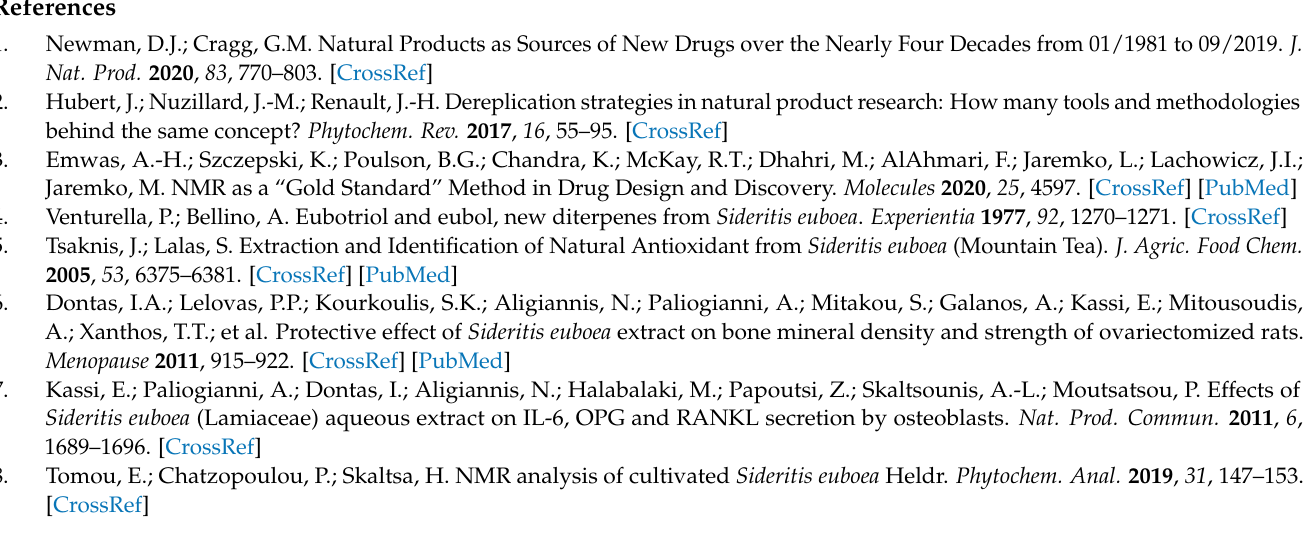
Supplementary Materials: Figure S1: 1 H-NMR spectrum of EtOAc residue of cultivated S. euboea (CD 3 OD, 400 MHz), Figure S2: COSY spectrum of EtOAc residue of cultivated S. euboea (CD 3 OD, 400 MHz), Figure S3: HSQC spectrum of EtOAc residue of cultivated S. euboea (CD 3 OD, 400 MHz), Figure S4: HMBC spectrum of EtOAc residue of cultivated S. euboea (CD 3 OD, 400 MHz), Table S1: Chemical structures of the isolated compounds 1–33, Figure S5: Best pose of the interaction of compound 12 with hyaluronidase. The pi-stacking interactions are shown with light blue dashed lines and the hydrogen bonds with yellow dashed lines. Figure S6: Best pose of the interaction of compound 13 with hyaluronidase. The pi-stacking interactions are shown with light blue dashed lines and the hydrogen bonds with yellow dashed lines. Figure S7: Best pose of the interaction of compound 17 with hyaluronidase. The pi-stacking interactions are shown with light blue dashed lines and the hydrogen bonds with yellow dashed lines. Figure S8 Best pose of the interaction of compound 18 with hyaluronidase. The pi-stacking interactions are shown with light blue dashed lines and the hydrogen bonds with yellow dashed lines. Figure S9. Best pose of the interaction of liquiritigenin with hyaluronidase, via Maestro software, showing liquiritigenin inside the cavity oh hyaluronidase interacting with the amino acid residues of the active